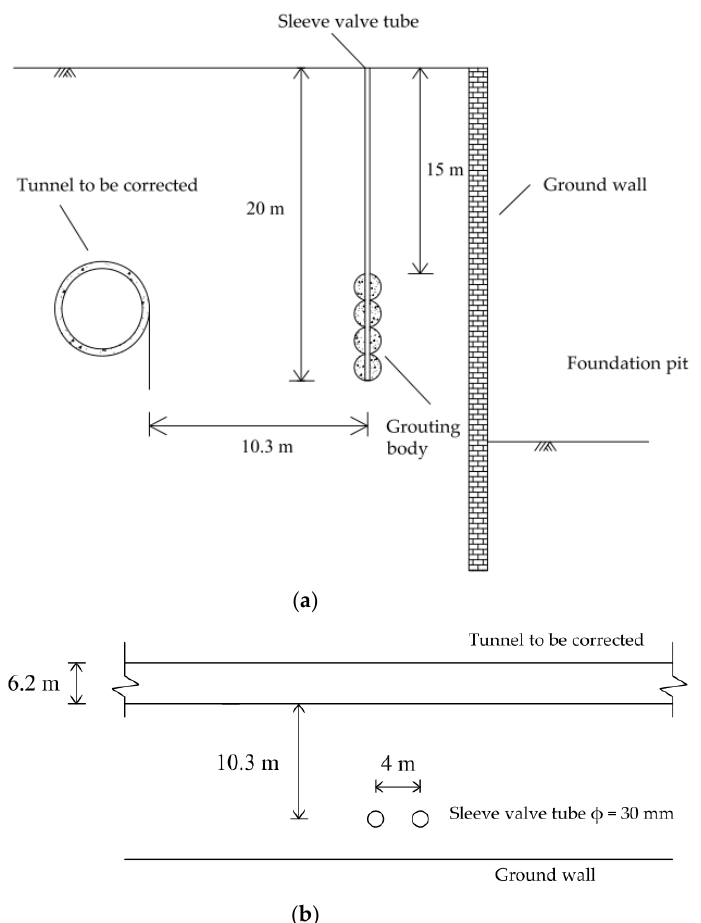
Figure 5. Layout of rectification of tunnel displacement by the sleeve valve pipe technique: ( a ) front view; ( b ) floor plan.